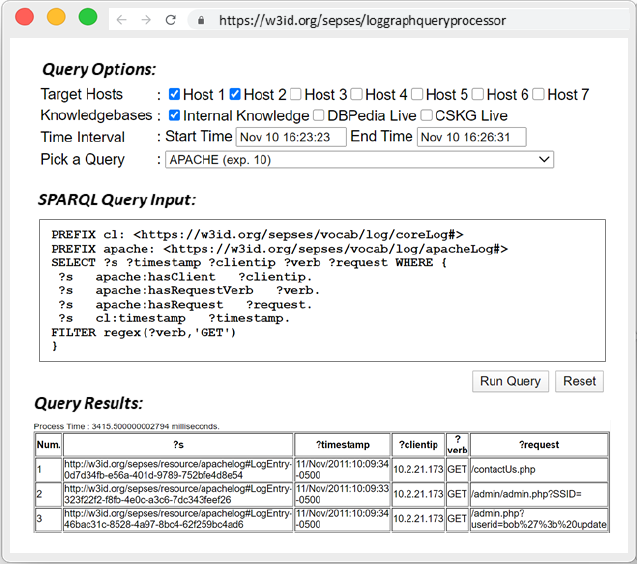
Figure 7. SPARQL query editor